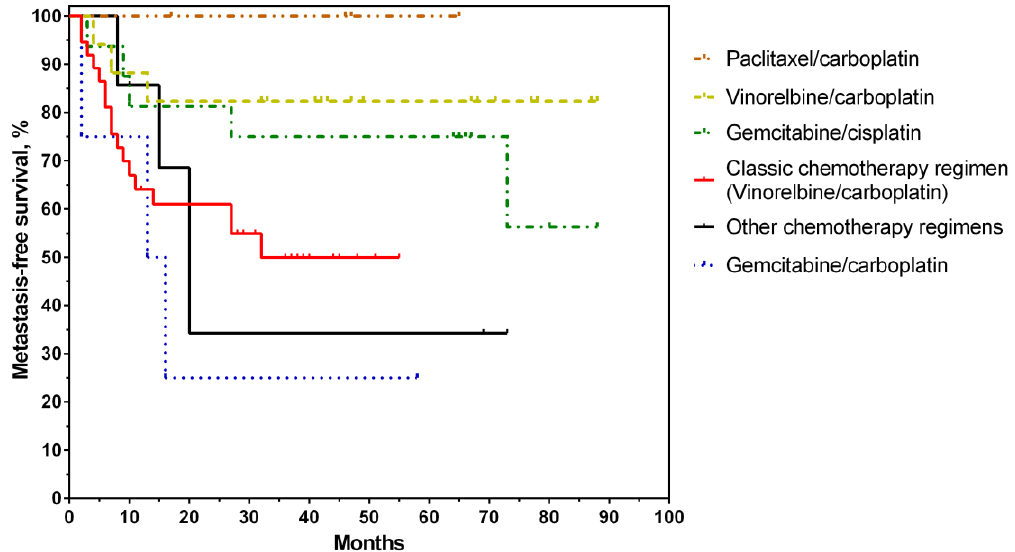
Figure 3. Metastasis-free survival curves of the study patients with non-small-cell lung cancer depending on the adjuvant chemotherapy regimen.